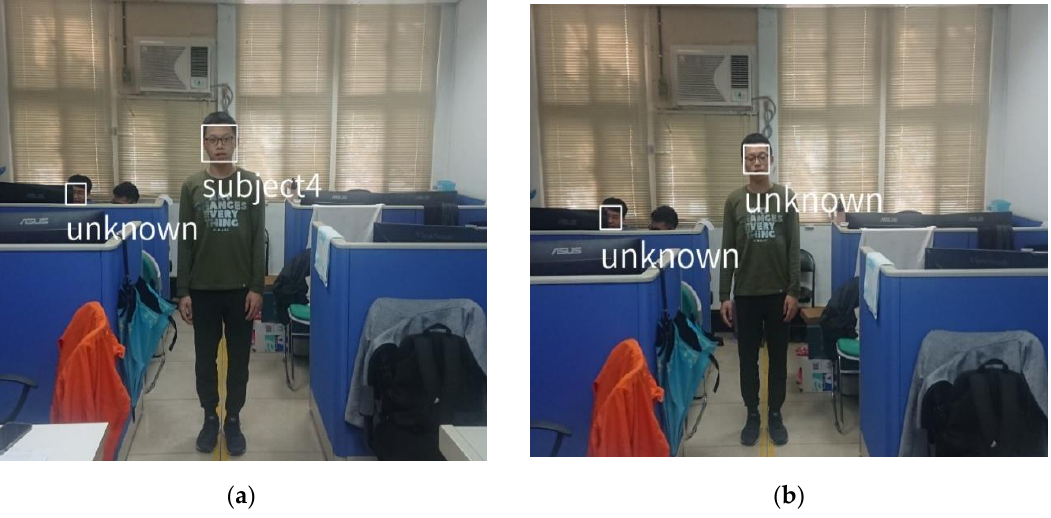
Figure 7. The performance of facial recognition, keeping the tolerances the same throughout (0.44). ( a ) The middle subject in the image is 0.68 cm and can be recognized. ( b ) The middle subject in the image is 0.47 cm and cannot be recognized.